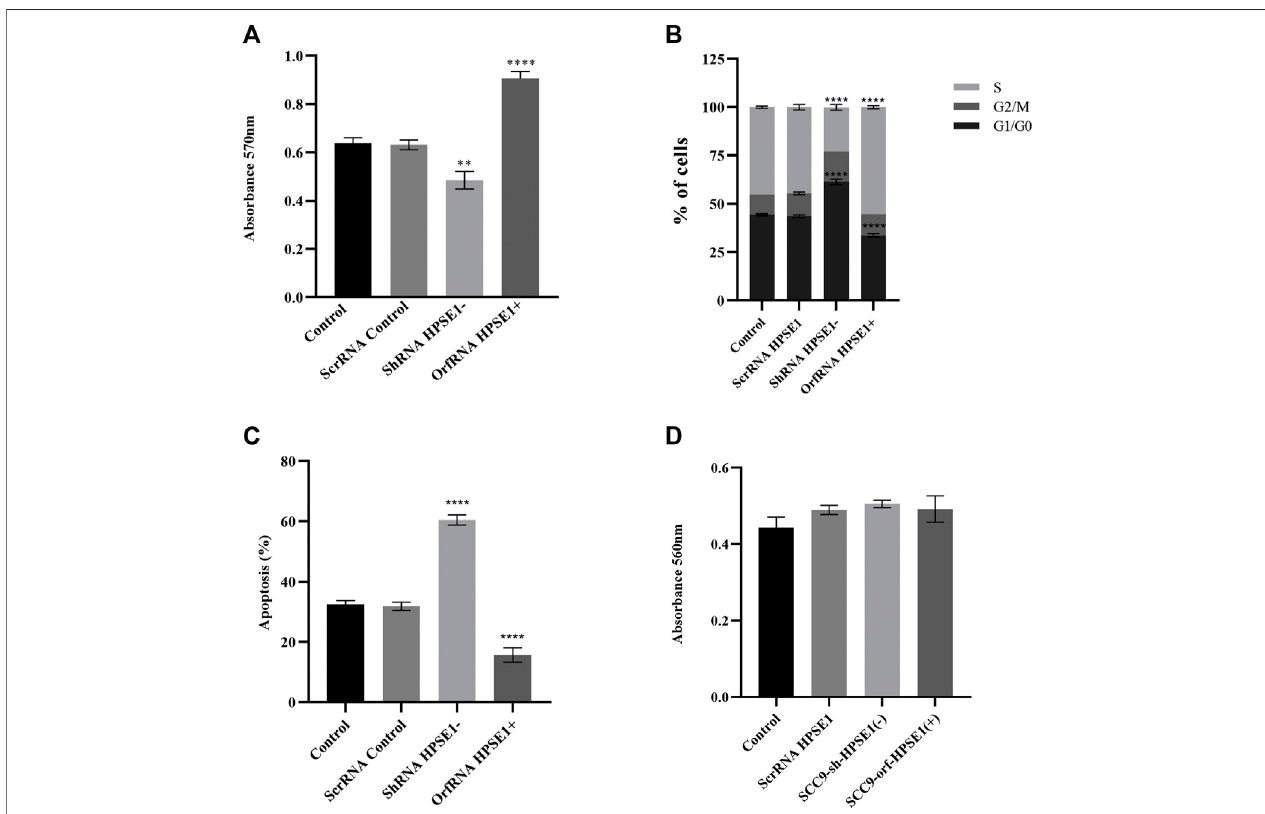
FIGURE4| DownregulationofHPSE1inhibitsproliferationandenhancesapoptosisofOSCCcells.CellsweresubjectedtoMTTcellproliferation (A) ,DNAcontentcellcycle analysis (B) ,andapoptosis (C) assays. (A) CellProliferationAssayoftheOSCCSCC9cellline(Control)comparedtoemptyvectorSCC9controlclone(ScrRNAcontrol),HPSE1 inhibitory/silencing SCC9-ShRNA HPSE1 − clone, and the HPSE1 overexpressing SCC9-OrfRNA HPSE1+ clone. (B) Quanti fi cation of cell cycle analysis was performed by fl ow cytometryafterstainingwithpropidiumiodidefortheSCC-9controlcellsandtherespectivesHPSE1-modulatedclones.AbrogationofHPSE1inducedarrestoftheSCC-9 cells cycle in G1 phase, and its upregulation signi fi cantly induced cell proliferation. (C) Flow cytometric analysis of apoptosis showed a remarkable increase in the number of apoptotic cells in HPSE1-silenced cells (ShRNA HPSE1 − ), while SCC-9 overexpressing HPSE1 (Orf-RNA HPSE1+) exhibited a reduction in apoptosis. (D) No signi fi cant differencesincelladhesionpropertieswereobservedamonganytransducedclonesmodulatingHPSE1expression,comparedtoparentalmock-transducedcells(control).Plots compose experimental triplicate analysis and were statistically calculated using ANOVA followed by Tukey ’ s test, where * p < 0.05, ** p < 0.01, *** p < 0.001, and **** p < 0.0001.